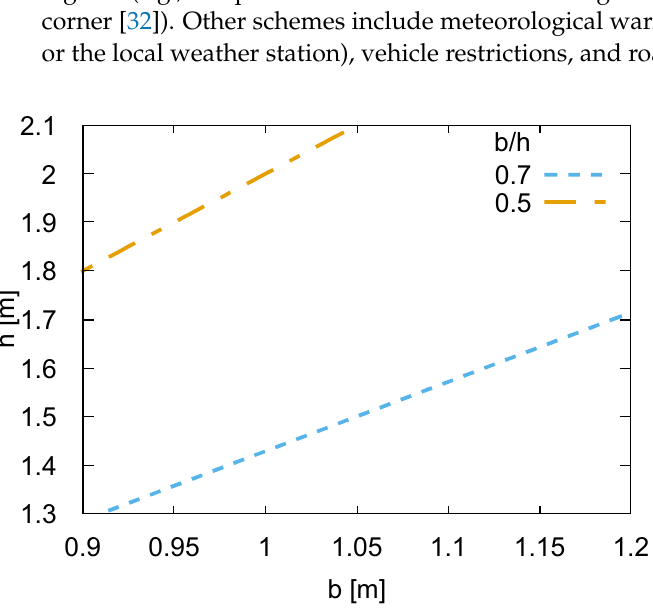
Figure 5. Relationships between half-track width b and height of the centre of mass h , meeting the safety condition.